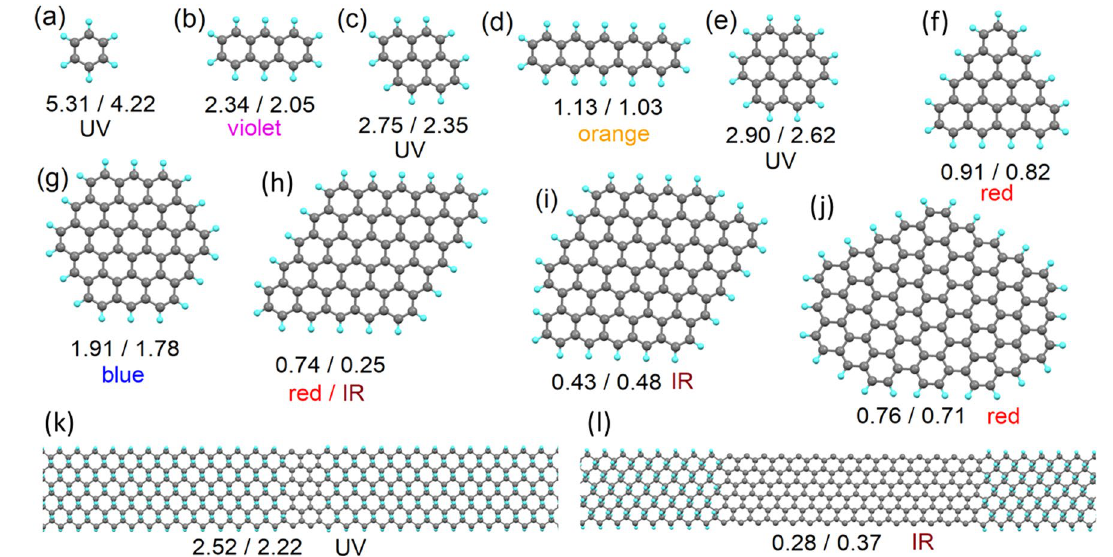
Fig. 2 a – j Optimised atomic structures of polycyclic aromatic hydrocarbons (PAHs) with morphologies of the carbon structures similar to sp 2 -islands in graphane, and k – l graphane supercells with armchair sp 2 -nanoribbons of different widths. The numbers under the pictures give the values of the calculated bandgaps in the PAHs or nanoribbons (first number) and in the sp 2 -islands or sp 2 -nanoribbons with the same morphology (second number). The expected PL colour (see Table 2) of each structure is also